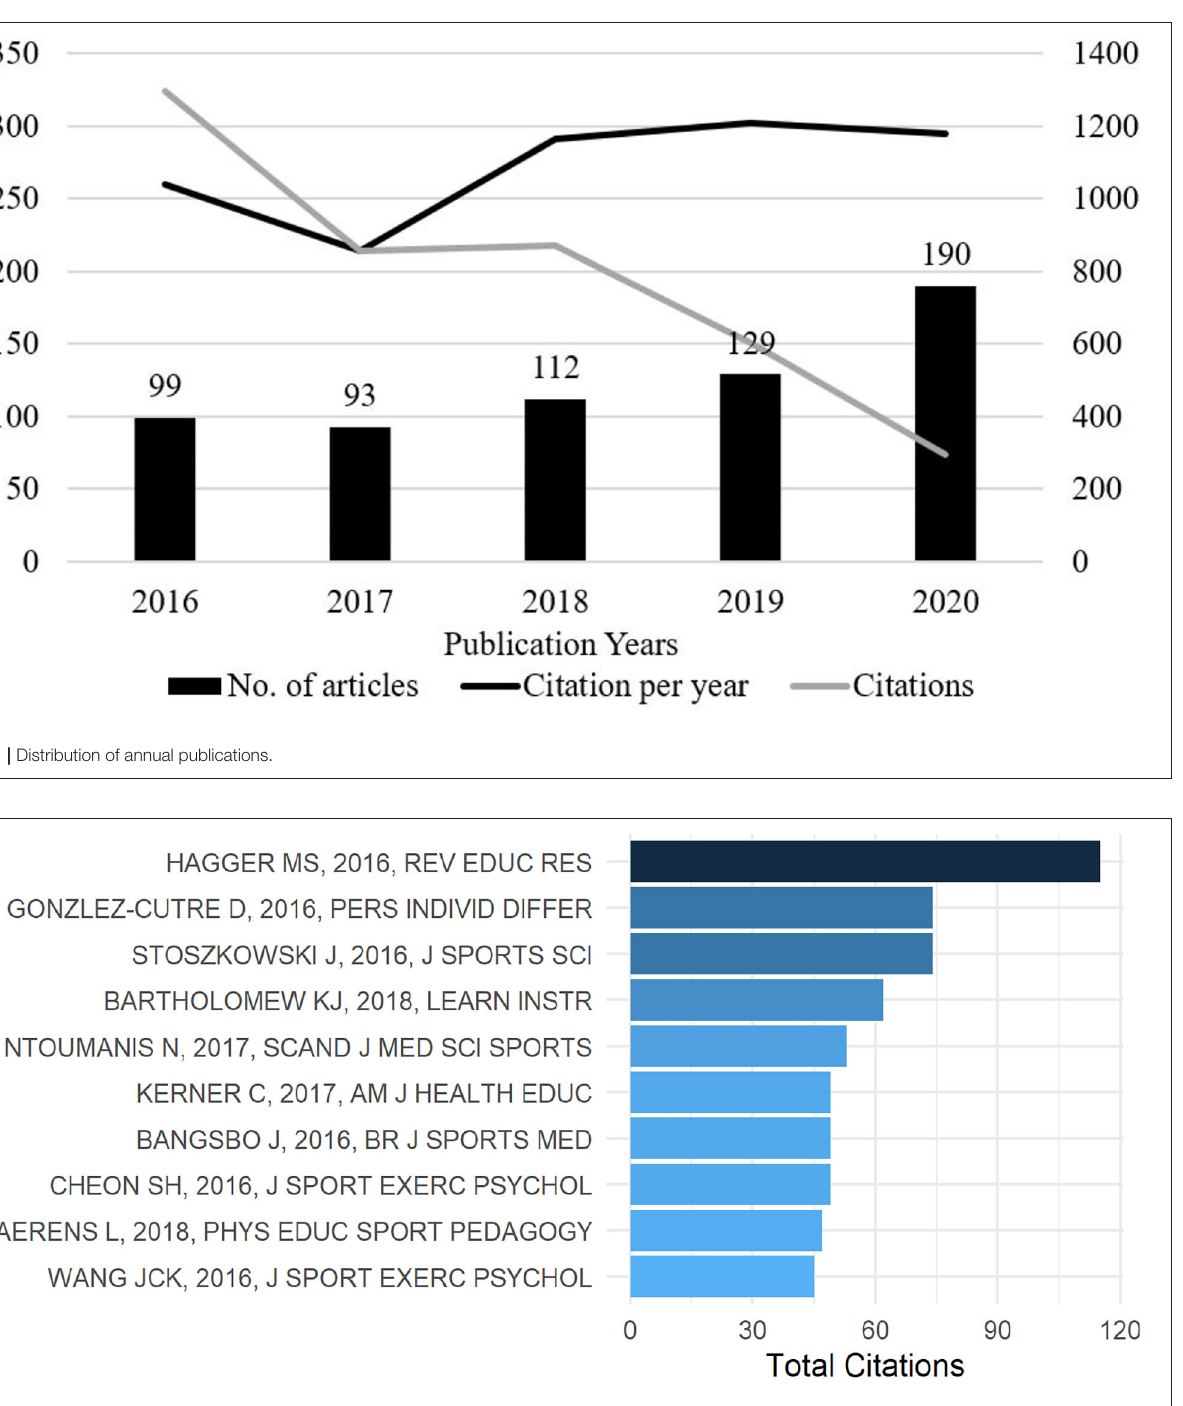
FIGURE 2 | Top 10 most-cited